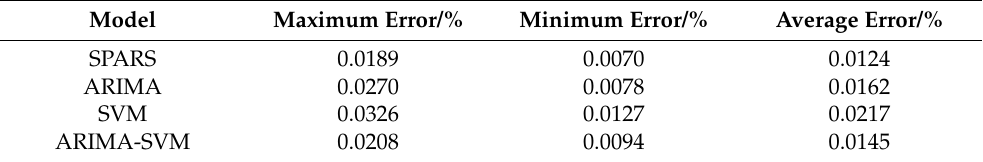
Figure 14. Comparison of prediction results of different models. Table 3. Comparison of the errors in the prediction results using different